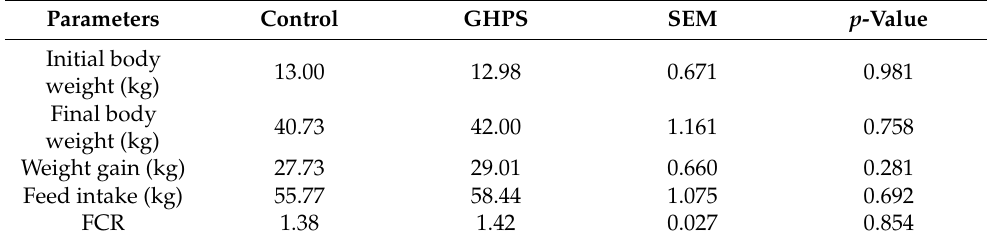
Table 2. Effect of a combined geothermal and solar heating system (GHPS) on the growth parameters.